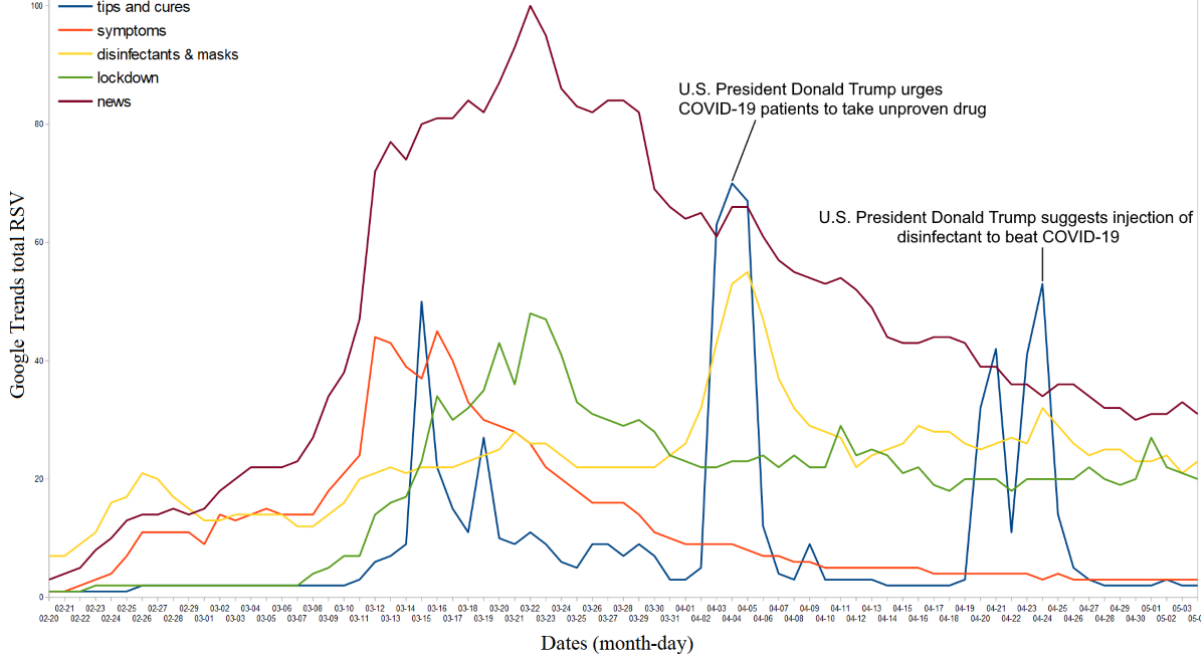
The top five nations most cited by global Instagram users in relation to COVID-19 were Italy (963,000 hashtags),